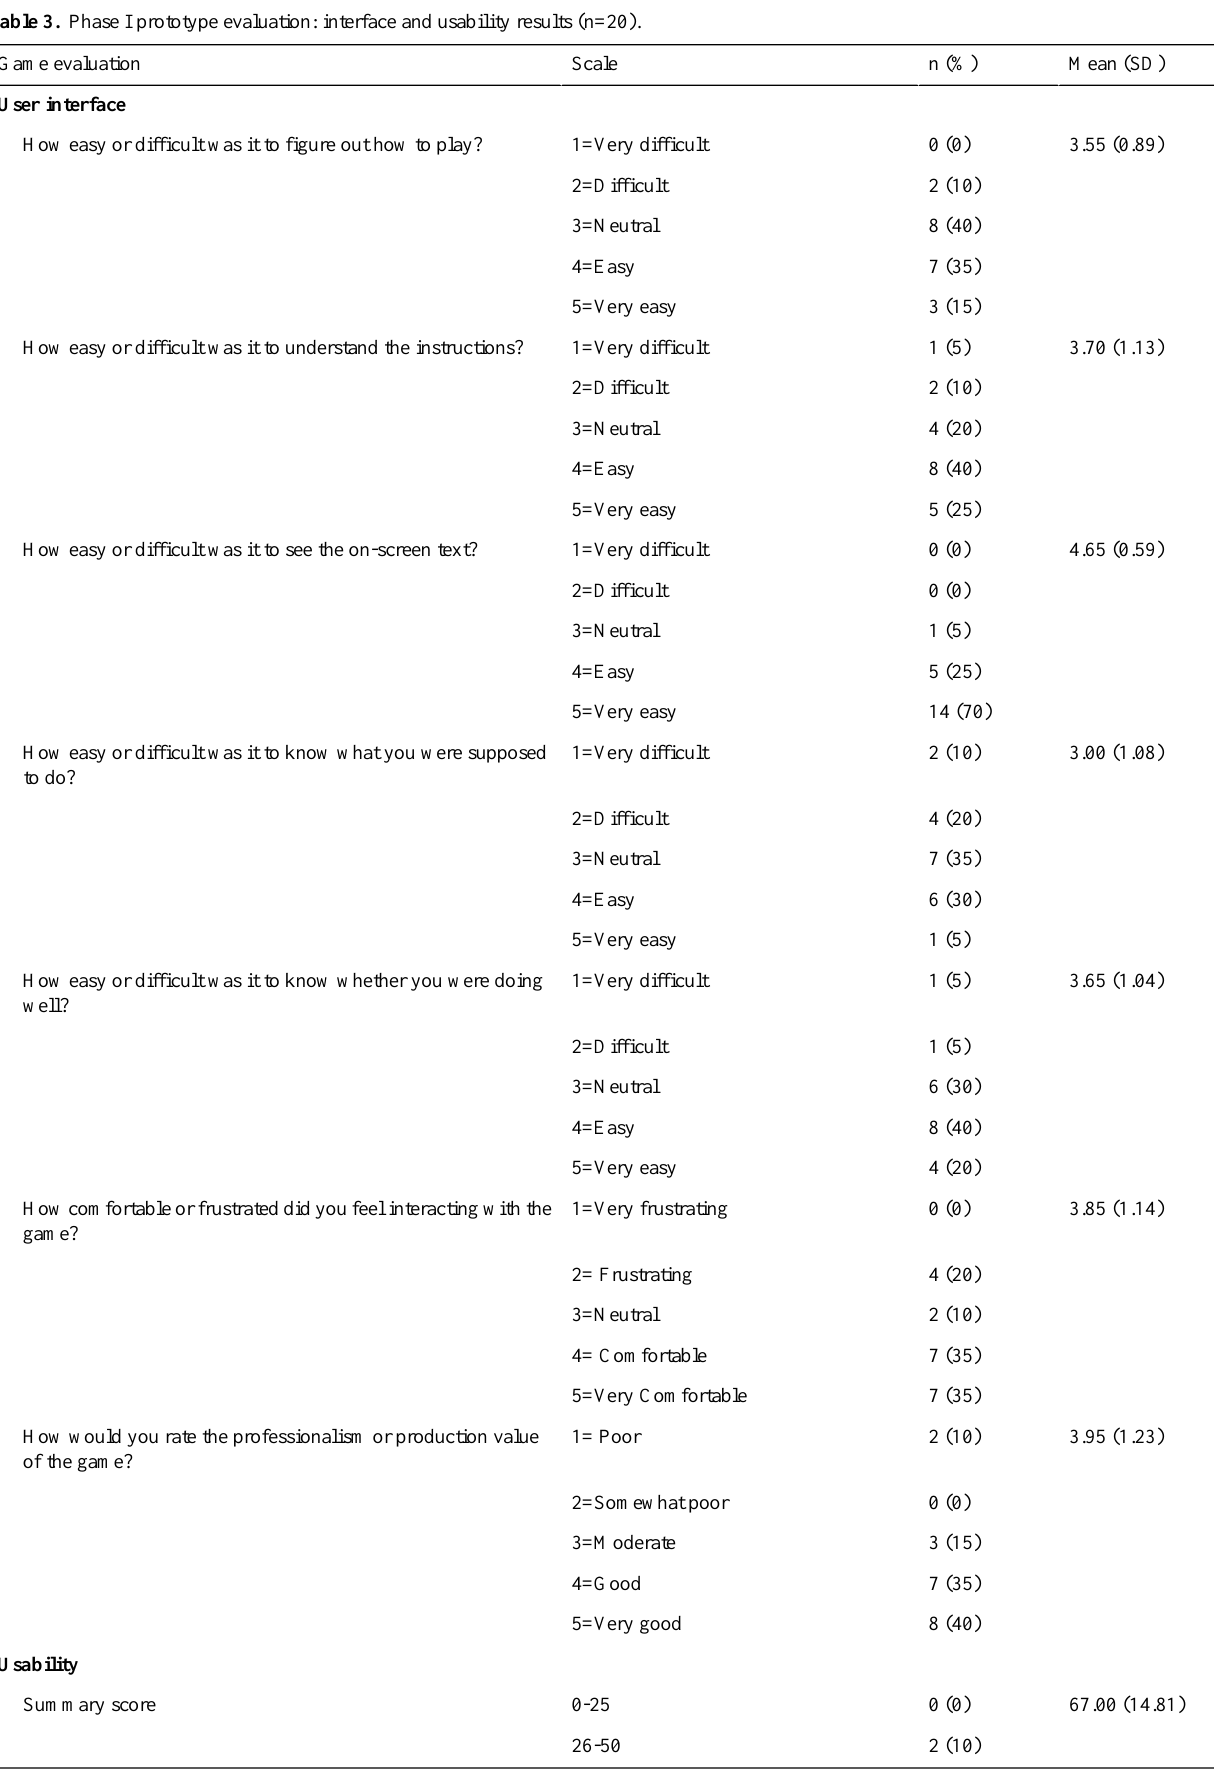
Table 3. Phase I prototype evaluation: interface and usability results